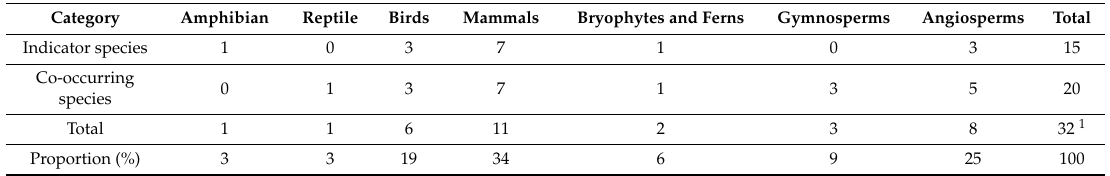
Table 2. Umbrella species composition.